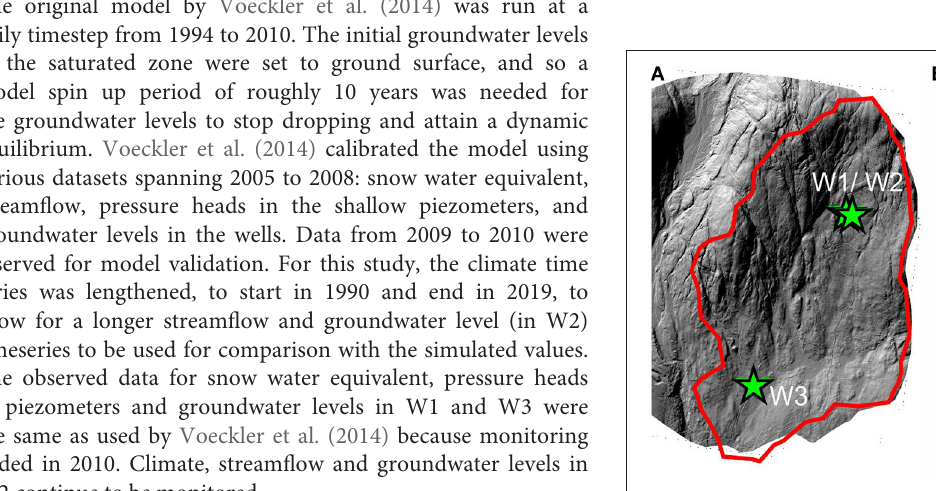
FIGURE 4 | Hillshade image for UPC 241 showing (A) the location of the bedrock wells (green stars) and (B) the interpreted network of fracture zones (also shown in Figure 2